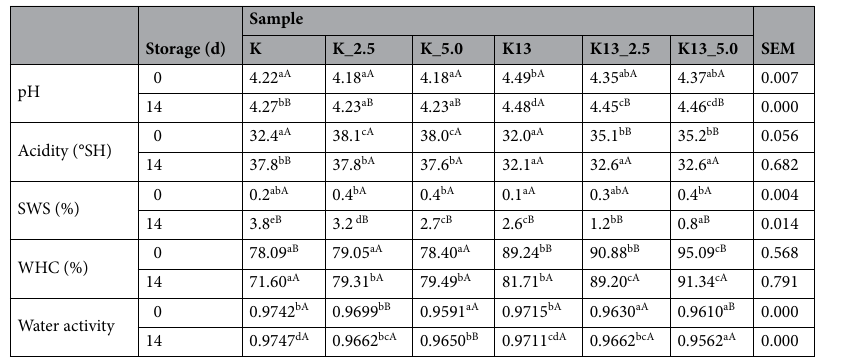
Table 2. Changes in physicochemical properties of kefir with honeydew honey during storage. K, model kefir; K13, commercial kefir; K_2.5, model kefir with 2.5% honeydew honey; K_5.0, model kefir with 5.0% honeydew honey; K13_2.5, commercial kefir with 2.5% honeydew honey; K13_5.0, commercial kefir with 5.0% honeydew honey; d, day; SWS, spontaneous whey syneresis; WHC, water holding capacity; SEM, standard error of the mean (n = 8). a–e, A–B Different lowercase letters in the superscript in rows and capital letters in columns for each parameter indicate statistically significant differences at the level α =